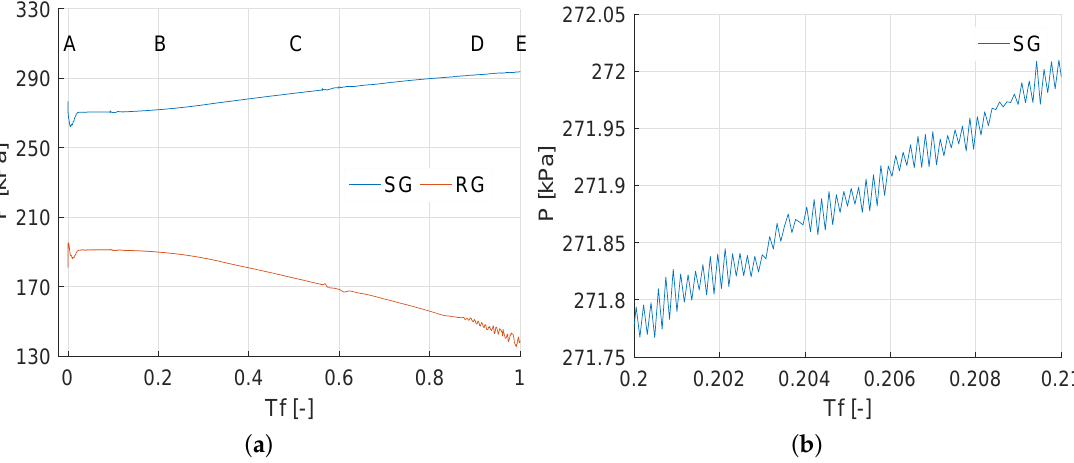
Figure 22. ( a ) Pressure trend at points in vaneless spaces; and ( b ) detailed view of a 0.01-s